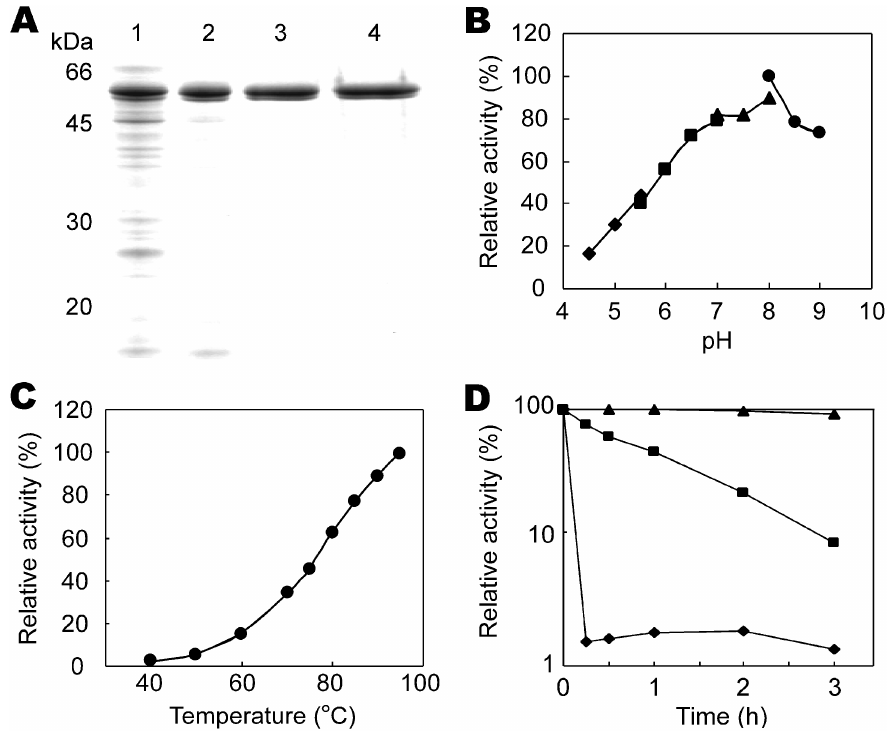
enzyme activity. (D) Thermo- stability of Tk -Mae.